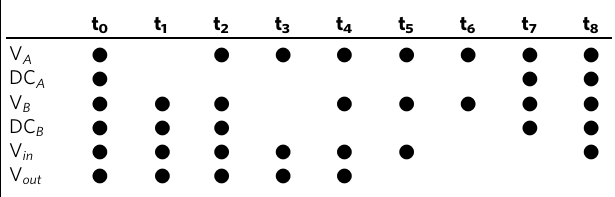
Table 2. The number of phases is reduced by two compared to the 1:1 mixer based on membrane valves. We found that the single- stage mixers with squeeze valves performed comparably to the membrane-valve based mixers.